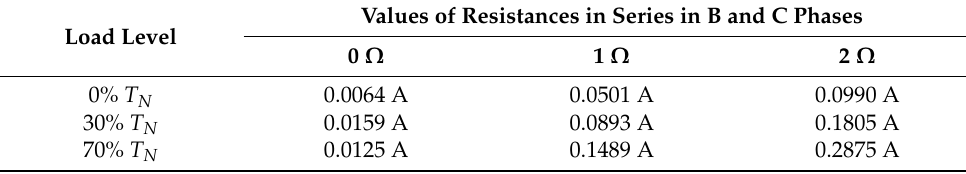
Table 3. Simulation data of motor negative sequence current.